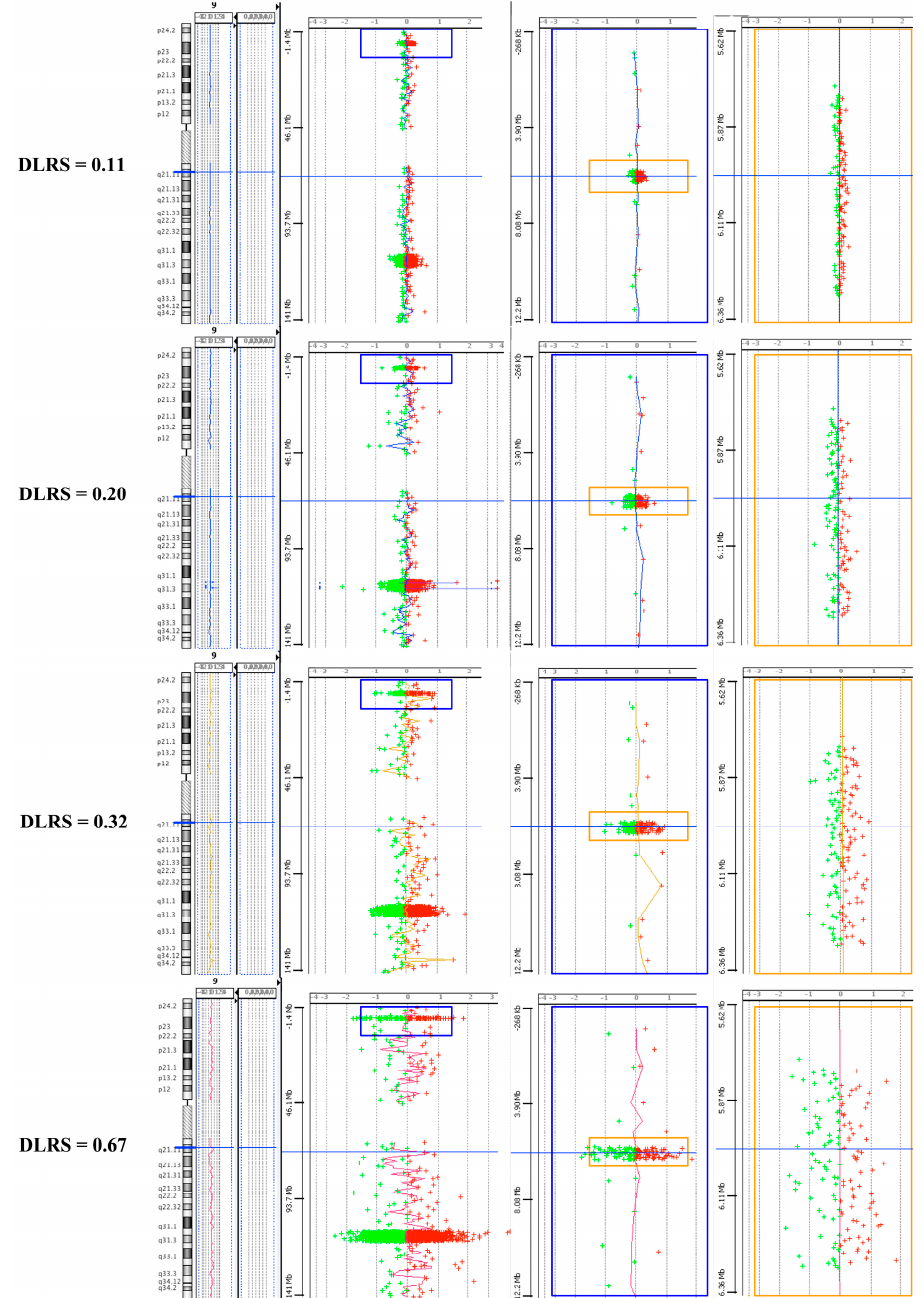
Figure 2. Sample profiles. An example of four samples selected for excellent quality, good, evaluate and very bad quality. For each, the profile at chromosome 9 is shown, including a region of probes scattered across the genome and two high density regions. The upper high density region inside the blue box in the left panel is zoomed in into the central panel (inside the large blue box) and the specific region inside the yellow box is further zoomed in into the right panel (inside the large yellow box).